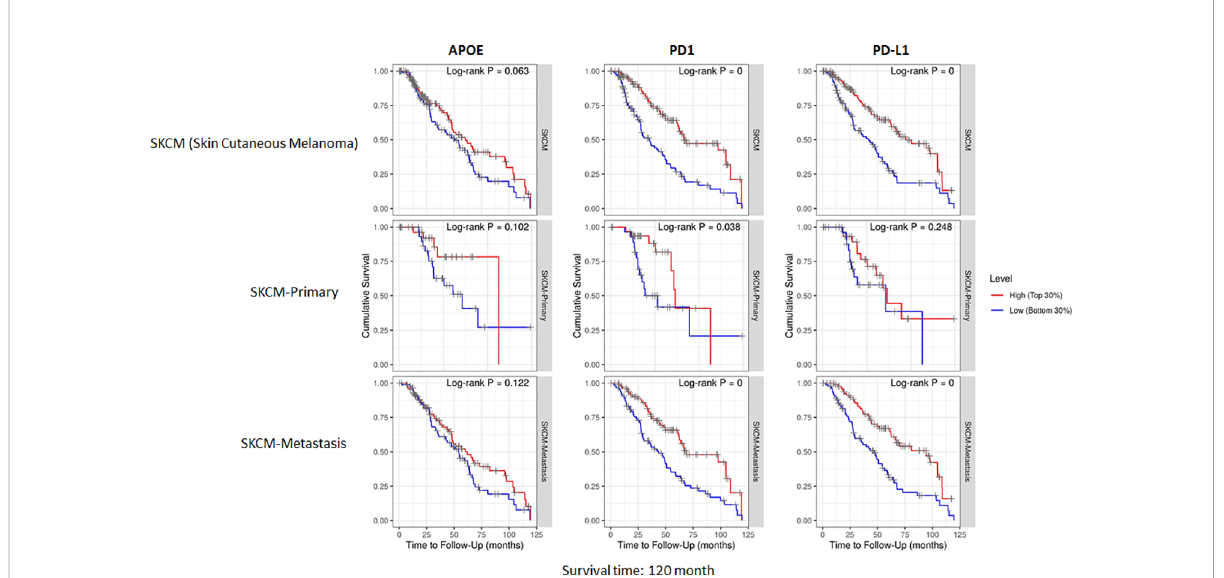
FIGURE 13 Cumulative survival of patients associated with bifurcate gene expression at 30%. TCGA database includes primary and metastasis samples (n=462). APOE expression did not associate with survival, while PD-L1 and PD1 was associated with survival at this level of analysis. The correlation was evaluated by the Spearman correlation coef fi cient with a cut-off value of 0.5 and P-value used a cut-off value of